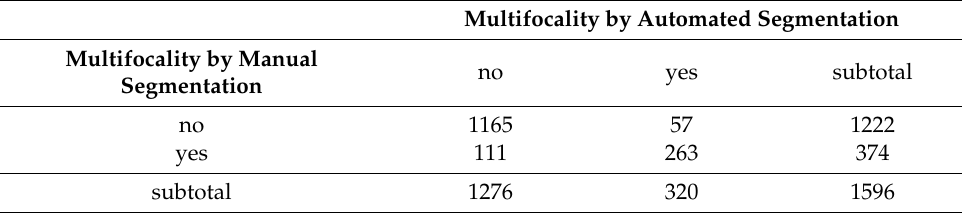
Table 4. Contingency table of multifocality between automated and manual segmentations. Multifocality by Automated Segmentation